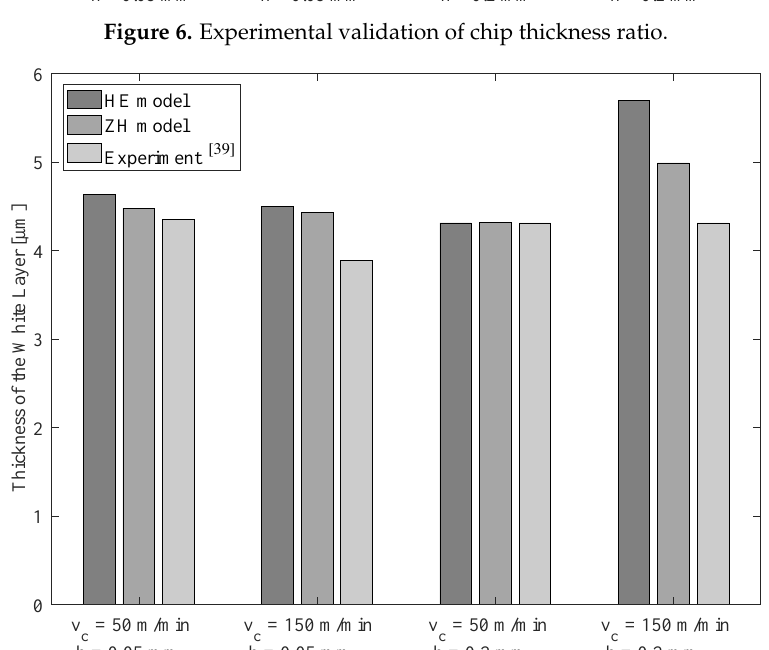
Figure 7. Predicted and experimentally measured White Layer thickness at different cutting